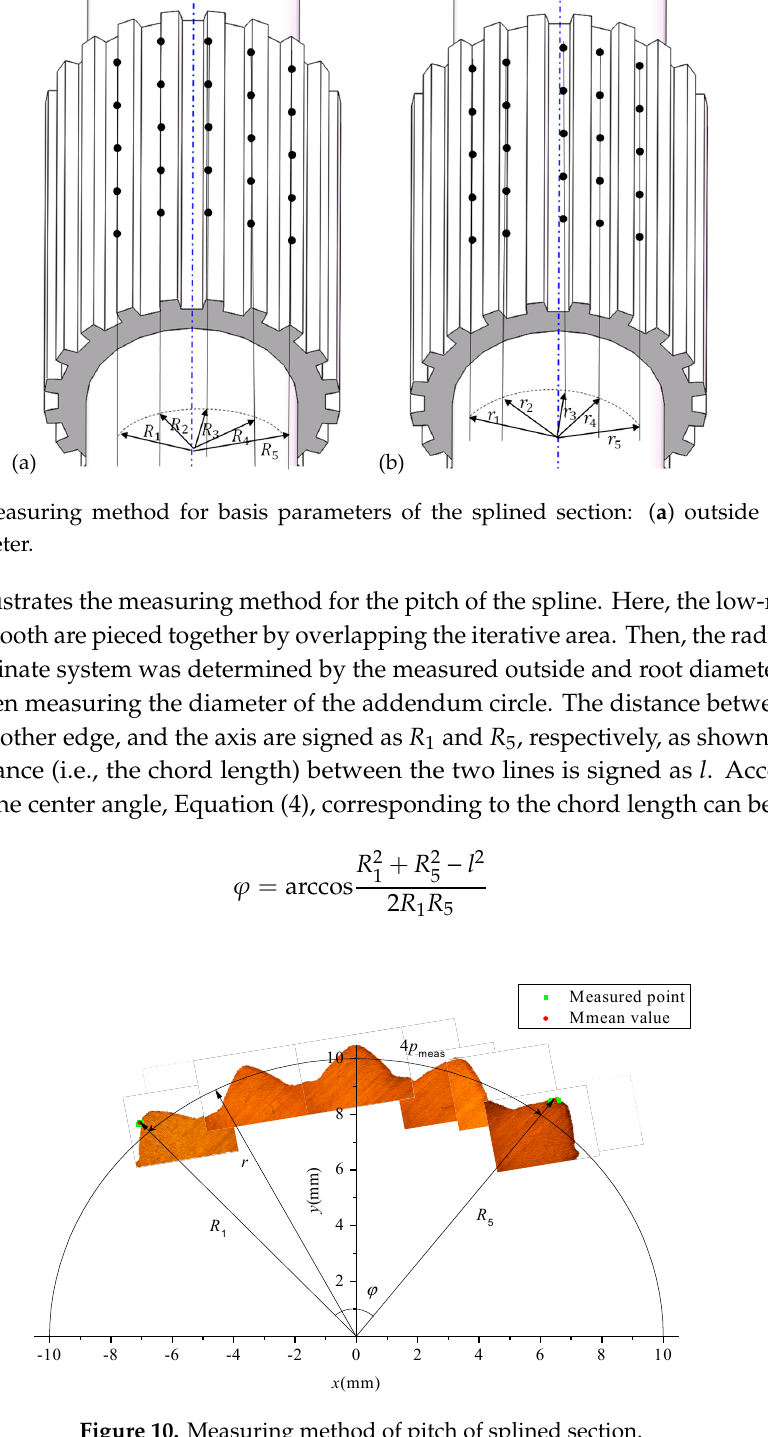
Figure 10. Measuring method of pitch of splined section.